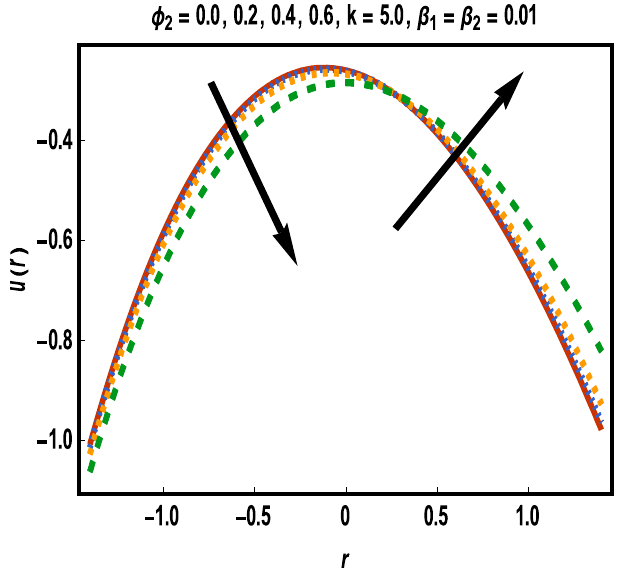
Figure 4. Results of case study 1: scenario 1 ( ϕ 2 ).